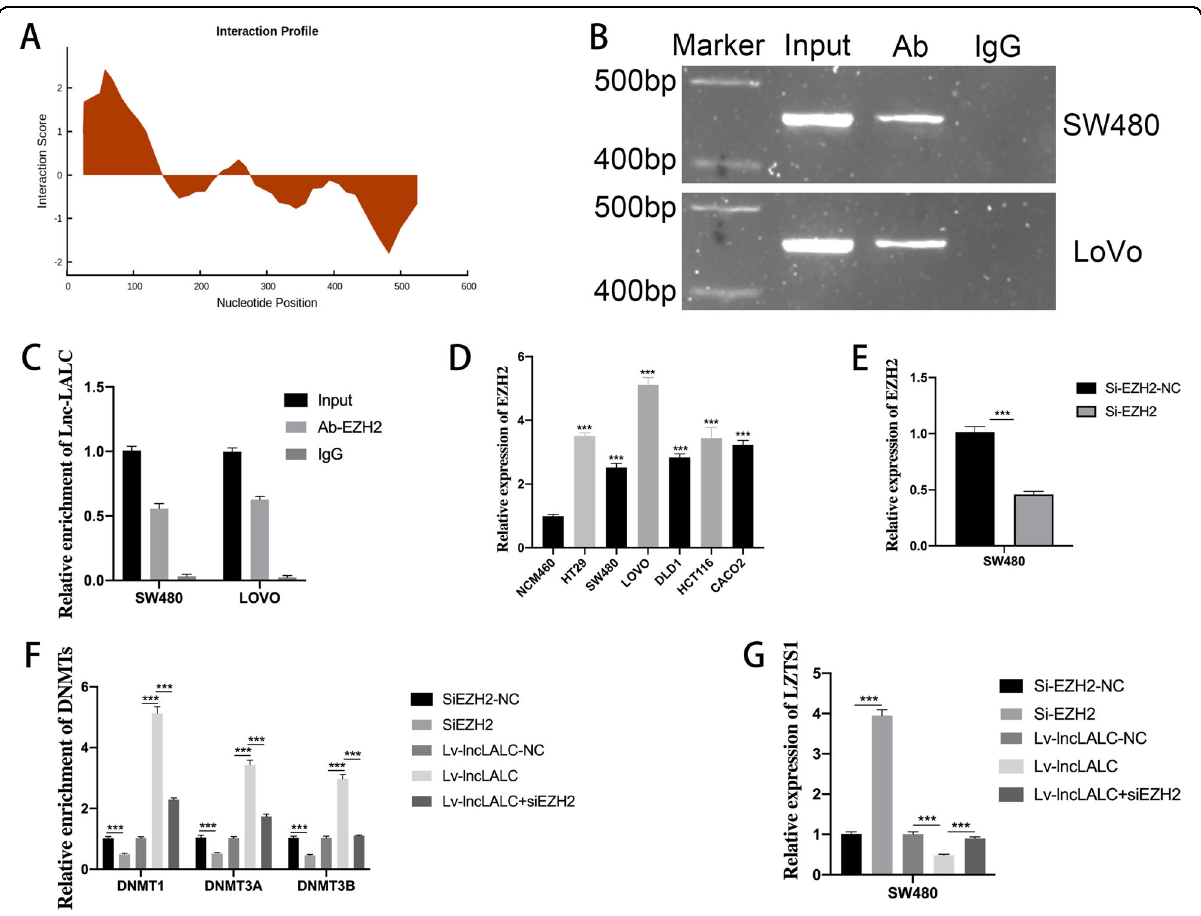
Fig. 6 LncLALC recruited DNA methyltransferases to the LZTS1 promoter regions by combining with EZH2. A Preliminary prediction by bioinformatics system showed that Lnc-LALC may have certain binding ability to EZH2. (http://service.tartaglialab.com/page/catrapid_group). B , C RIP test using the EZH2 antibody showed that there was a strong combining capacity between lncLALC and EZH2 in SW480 cells and LOVO cells. D qRT- PCR showed that EZH2 was elevated in CRC cells than NCM460 cells. E The silencing ef fi cacy of EZH2 in SW480 cells was determined by qRT-PCR. F The CHIP results showed that siEZH2 could reduce the enrichment of DNMT1, DNMT3A, DNMT3B in LZTS1 promoter and could also reverse the DNMTs , high enrichment induced by Lv-lncLALC in SW480 cells. G qRT-PCR showed that siEZH2 could increase LZTS1 expression level and abolish the suppression of LZTS1 induced by Lv-lncLALC in SW480 cells. * P < 0.05; ** P < 0.01; *** P <